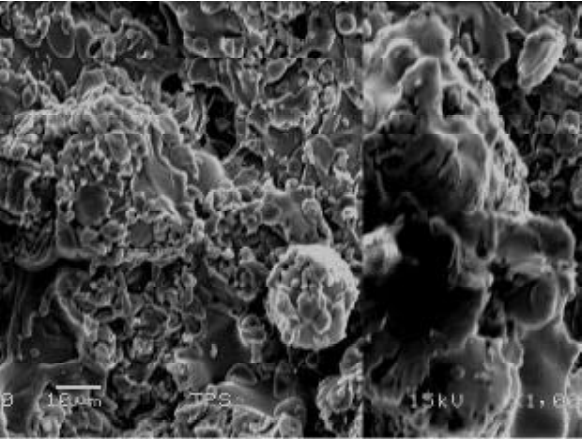
FIGURA 5- Limite entre a porção rugosa e transmucoso polido. Observar a dissipação de resíduos (seta) (x200)